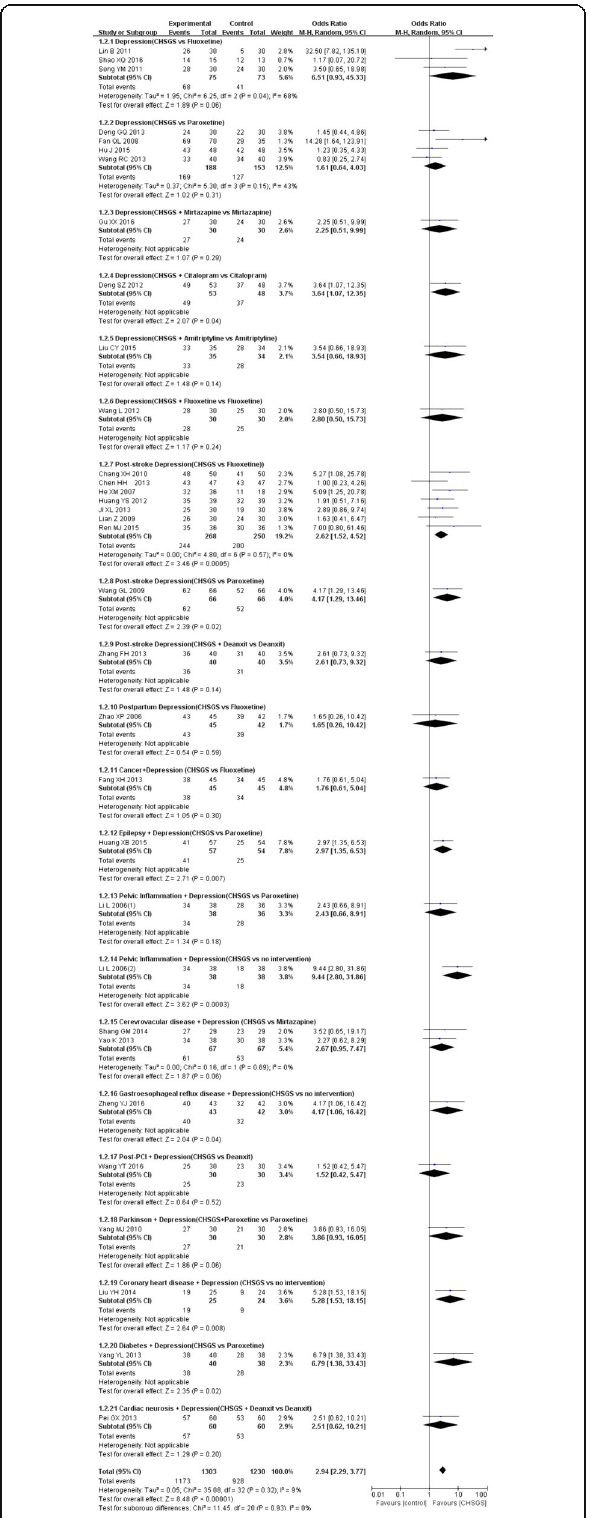
Fig. 4 Forest plot for efficacy rate of Chai Hu Shu Gan San in treating